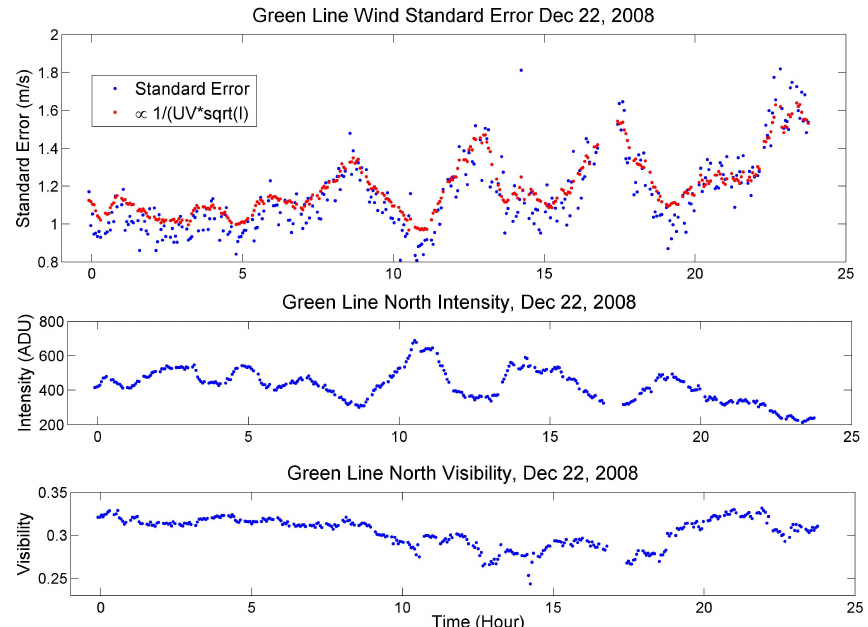
Fig. 7. Comparison of the standard error (blue points) for northern sector compared to the σ w (red points). Below this panel the corresponding detected signal (in ADU, middle panel) and visibility (lower panel) as a function of time for the same day are shown. Decreases in the standard error are mainly associated with increases in the signal as expected given the visibility stays roughly constant throughout the day.